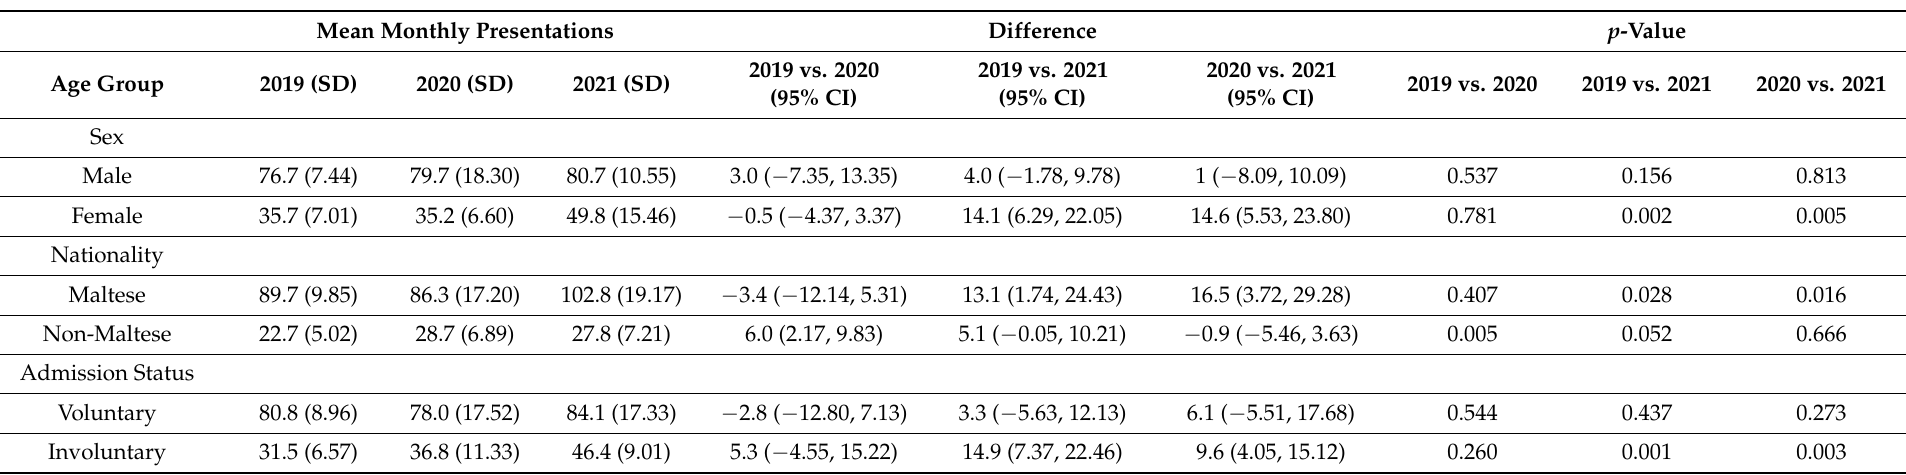
Table 2. Cont. Mean Monthly Presentations